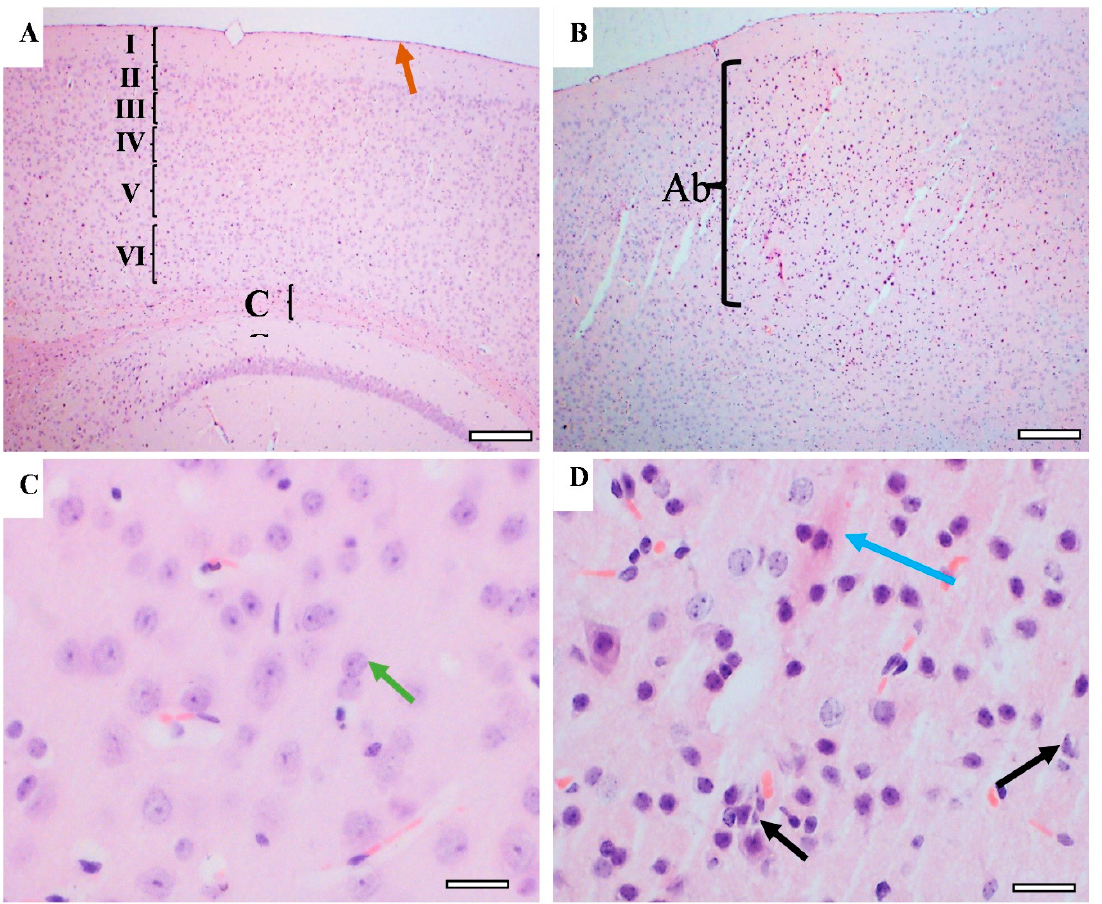
Figure 11. The effect of CUMS on the frontal cortex. Representative frontal cortex areas stained with H&E from controls ( A , C ) and CUMS ( B , D ). The control frontal cortex showed the pia matter (brown arrow) and 6 cortical layers (from I to VI) and part of the corpus callosum (CC) in low-power images ( A ). The cortical layers disrupted by abnormal cellular overgrowth area (Ab) in CUMS frontal cortex ( B ). The high-power image observed normal neurons with large vesicular nuclei and clear nucleolus and chromatin materials in the control frontal cortex (green arrow) ( C ). The cellular overgrowth area in CUMS cortex contains degenerated neurons (black arrow), eosinophilic extracellular plaques (blue arrow), and neurons with dark basophilic nuclei without clear nucleolus. ( D ). Scale bar A,B = 200 µm, C,D = 20 µm.